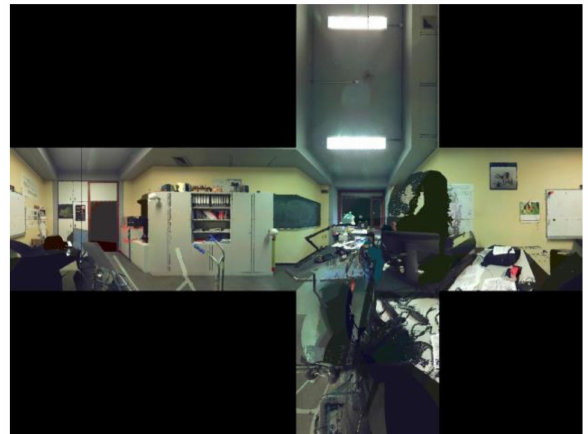
Figure 11. The resulting cubemap of the inverse